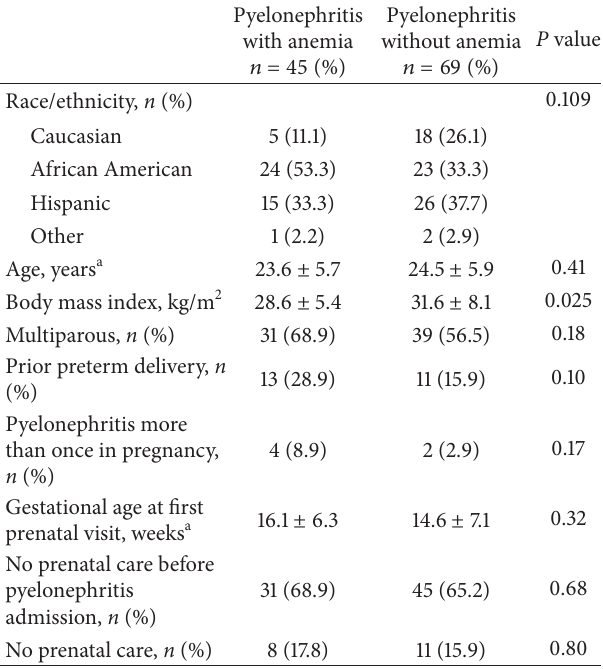
Table 1: Patient